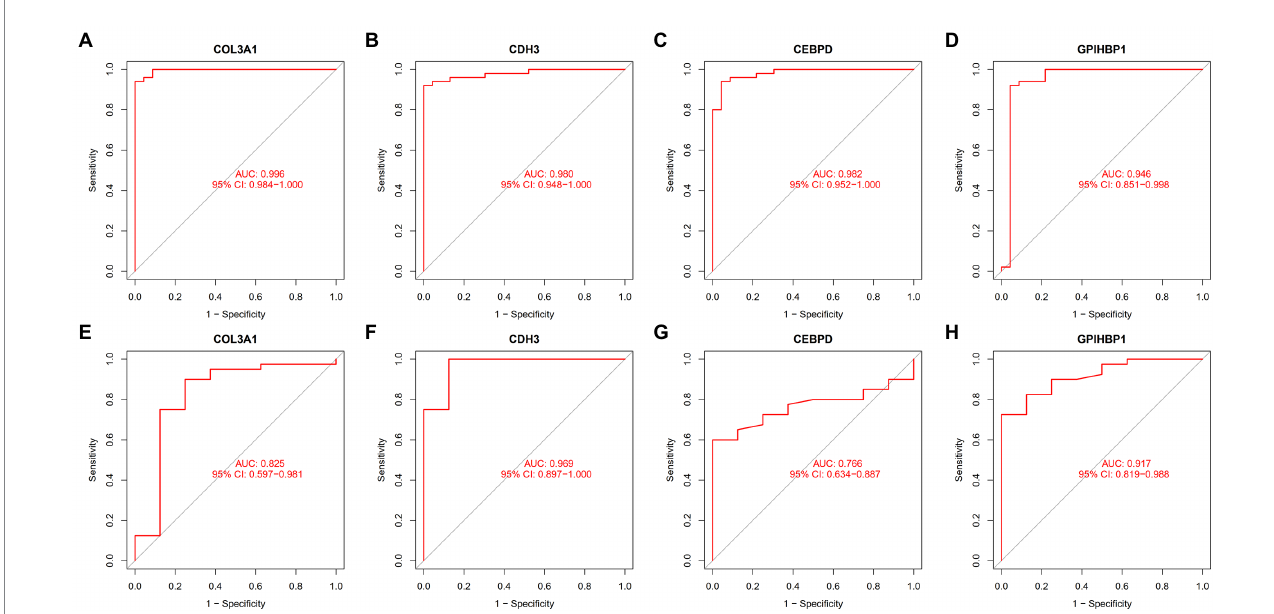
FIGURE 5 ROC curves demonstrating the diagnostic efficiency of the four candidate biomarkers. (A) ROC curve of COL3A1 after fitting to one variable in the metadata cohort. (B) ROC curve of CDH3 after fitting to one variable in the metadata cohort. (C) ROC curve of CEBPD after fitting to one variable in the metadata cohort. (D) ROC curve of GPIHBP1 after fitting to one variable in the metadata cohort. (E) ROC curve of COL3A1 after fitting to one variable in the GSE53845 dataset. (F) ROC curve of CDH3 after fitting to one variable in the GSE53845 dataset. (G) ROC curve of CEBPD after fitting to one variable in the